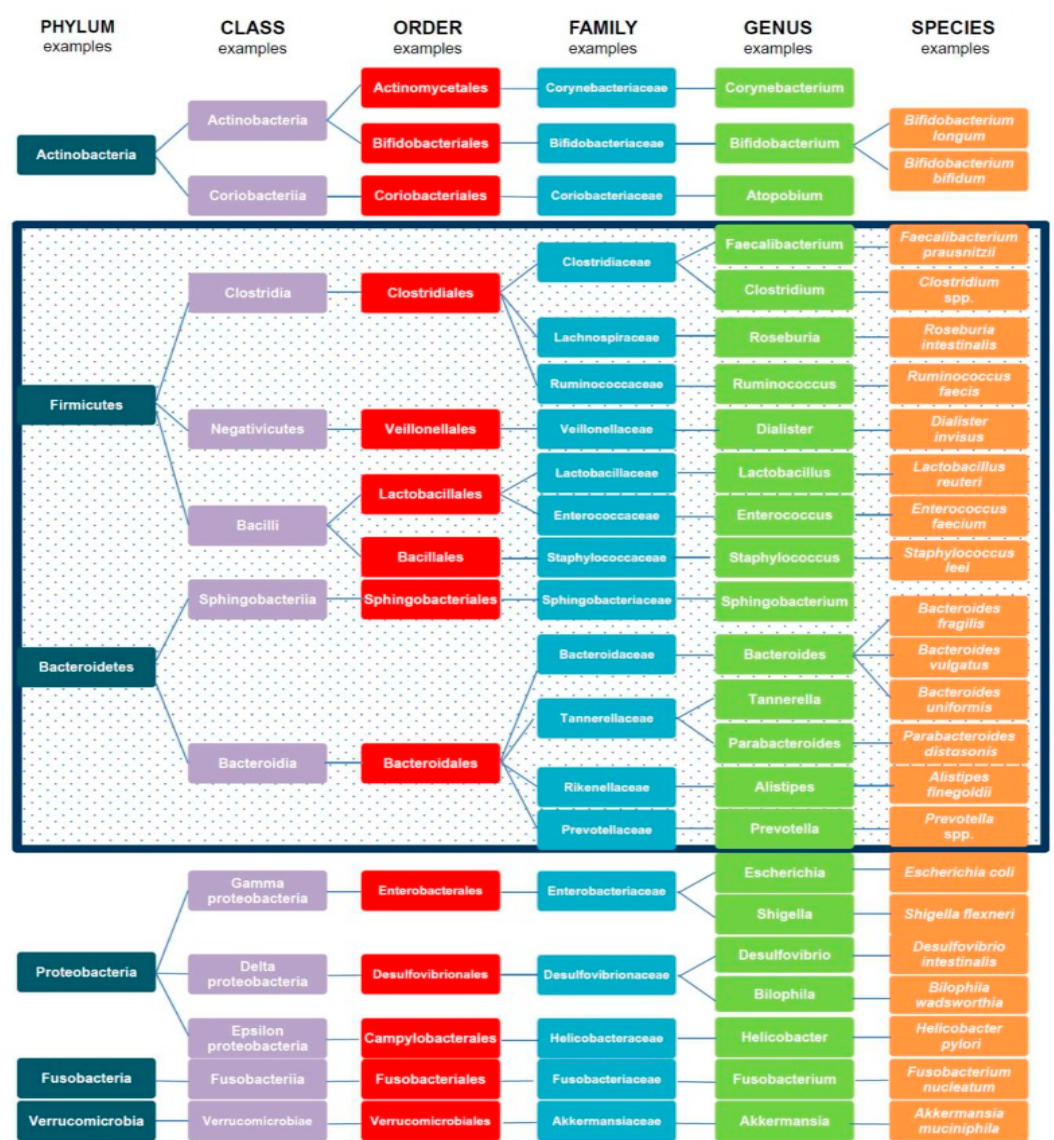
Figure 1. Bacterial types in the microbiome. Firmicutes and Bacteroidetes in the highlighted box represent approximately 90% of the total gut microbiota. Note. Adapted from [51].